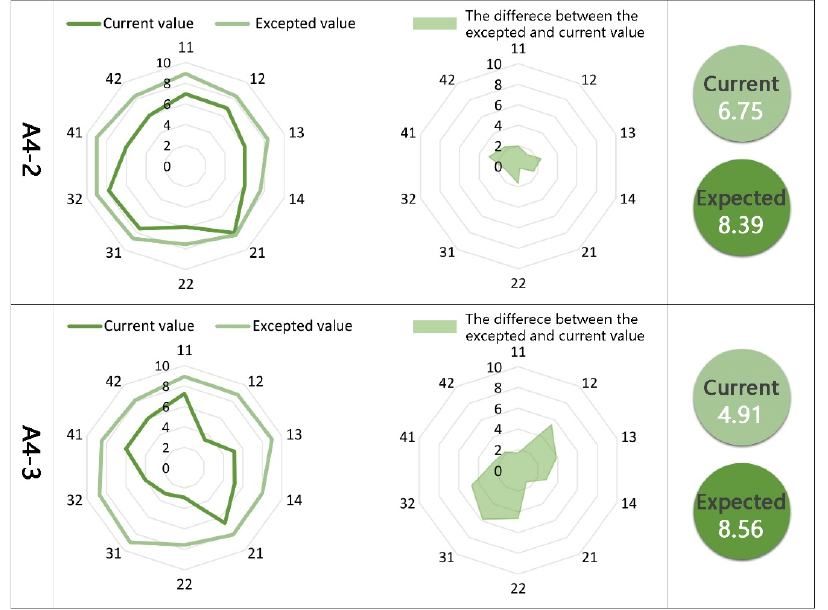
Figure 8. Radar maps of A4-2 and